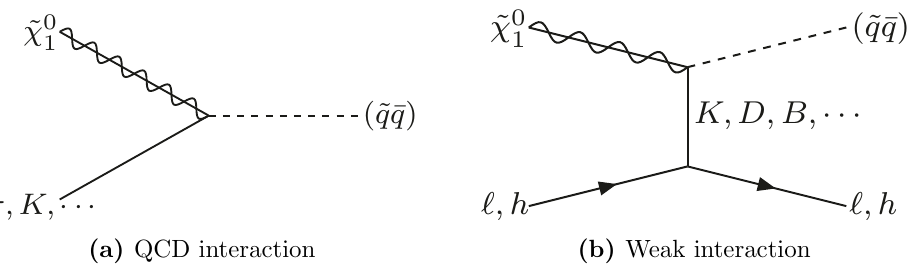
Figure 3. Diagrams for the conversion between the neutralino and